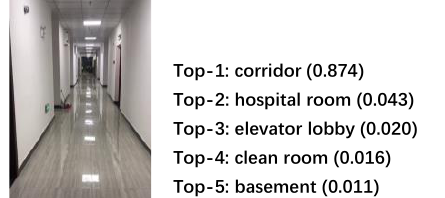
Figure 4. A test picture for scene recognition. The top 5 predictions and their probabilities are shown on the right.